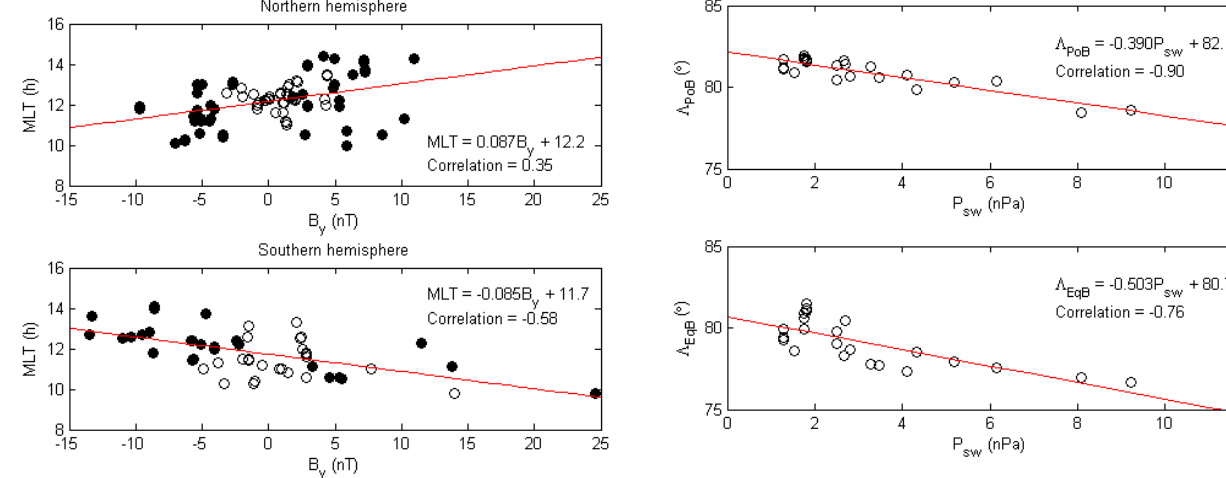
Fig. 14. Magnetic local time of cusp crossings (under steady IMF) as a function of IMF- B y . Filled circles correspond to cases with | B y | > | B z | .